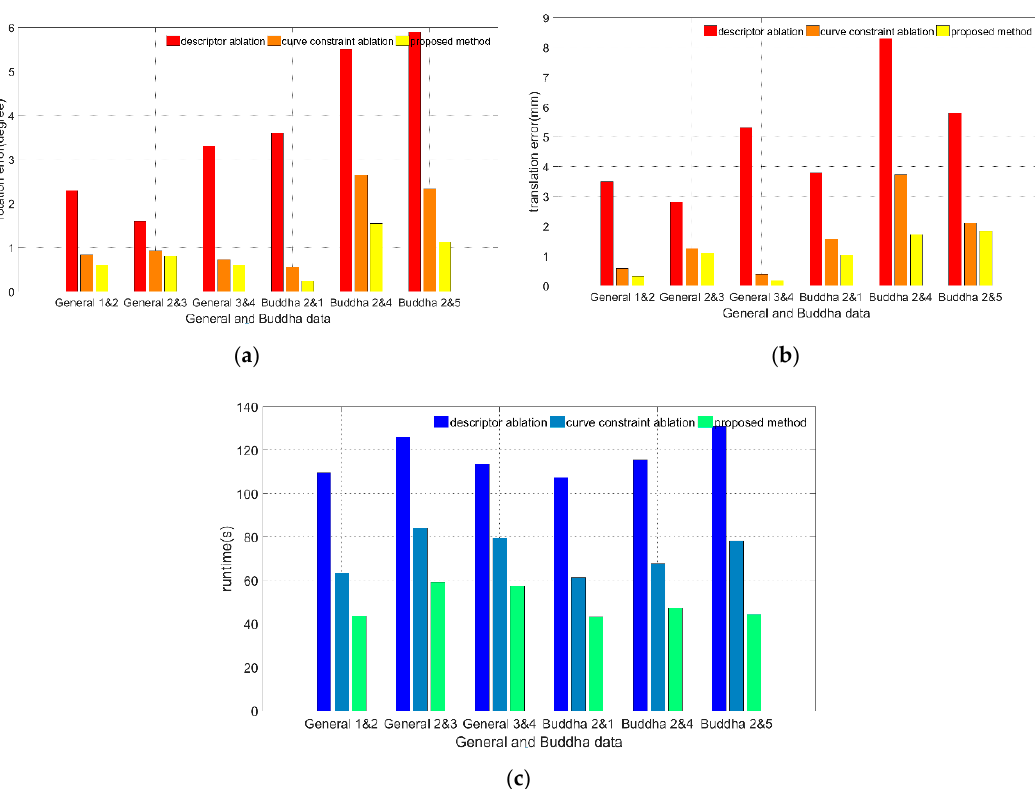
Figure 16. Results of ablation study: ( a ) rotation error evaluation, ( b ) translation error evaluation, and ( c ) runtime evaluation.